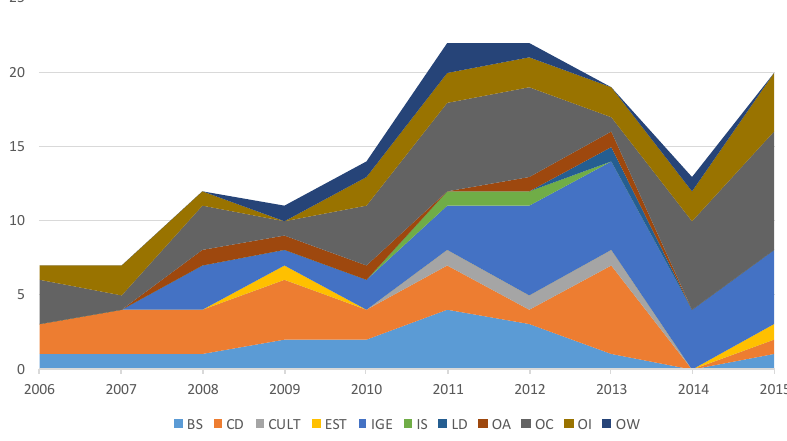
Fig. 5. Inner parts of the NCD Model addressed per year, 2006 - 2015